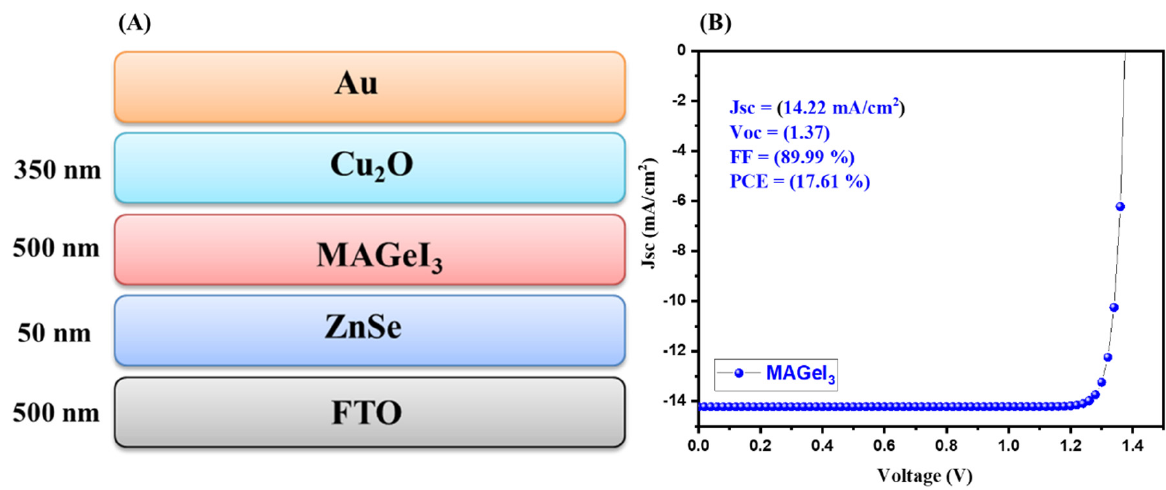
Figure 1. Schematic device structure ( A ) and J–V curve ( B ) of MAGeI 3 -based PSCs.